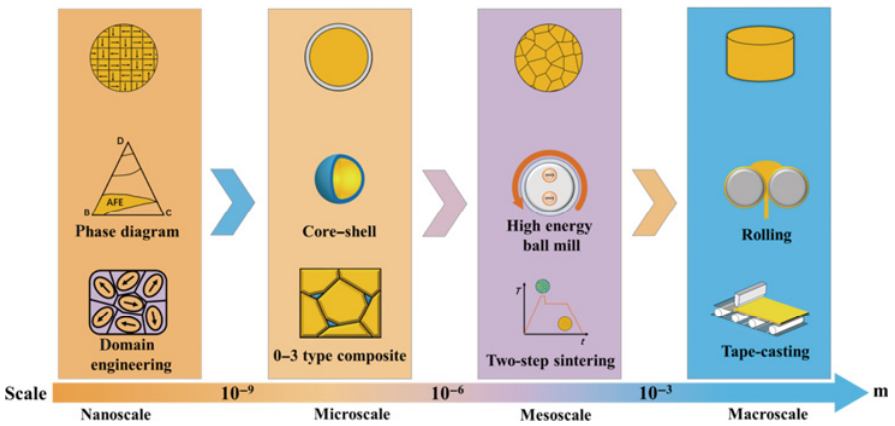
Fig. 4 Structures and optimization strategies of ceramic capacitors at different